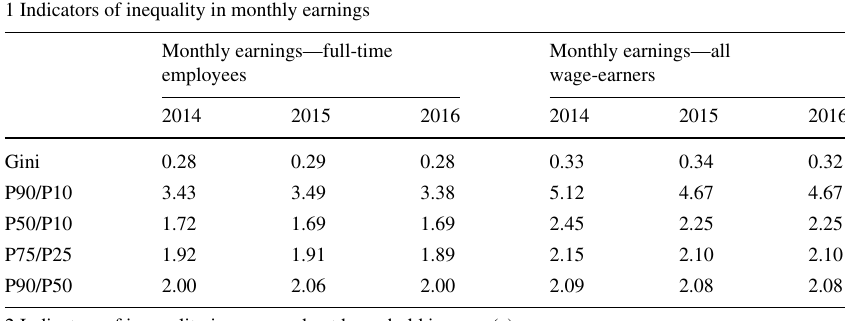
Table 7 Indicators of earnings and income inequality during the recovery period. Source : INE (Spanish Labour Force Survey and Survey of Income and Living Conditions) 1 Indicators of inequality in monthly